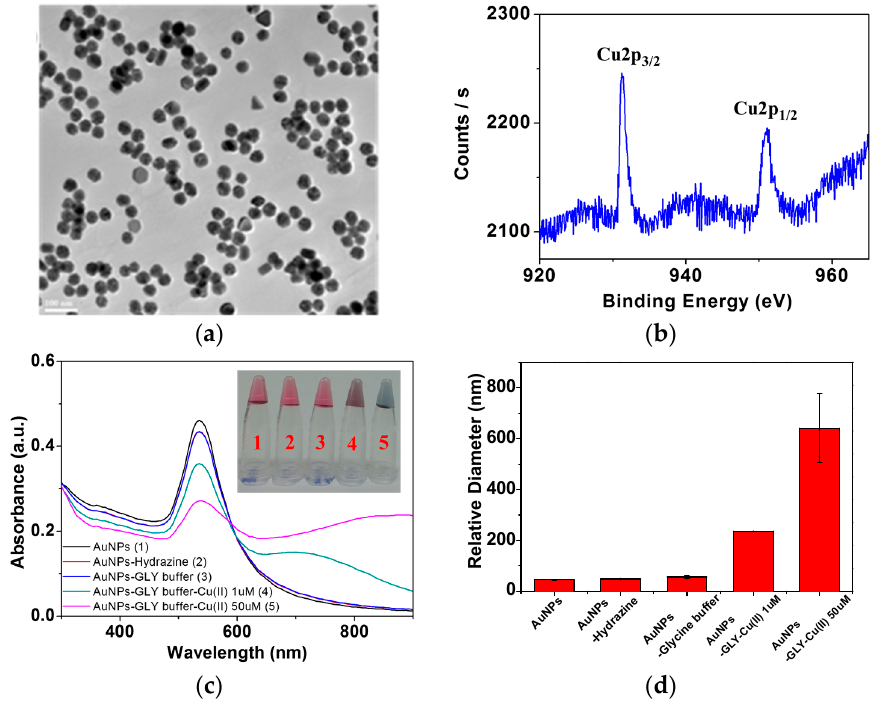
Figure 2. ( a ) TEM image and ( b ) XPS spectrum of GLY-Cu 2+ on AuNPs; ( c ) UV-Vis absorption spectra. The inset shows a photo of the AuNP solutions in the (1) absence and (2) presence of hydrazine, (3) glycine buffer and glycine buffer-Cu 2+ with [Cu 2+ ] = 1 and 50 µM in (4) and (5), respectively; ( d ) Stick diagram of relative hydrodynamic diameters of GLY-Cu 2+ on AuNPs in the [Cu 2+ ] concentration range of 1 and 50 µM.